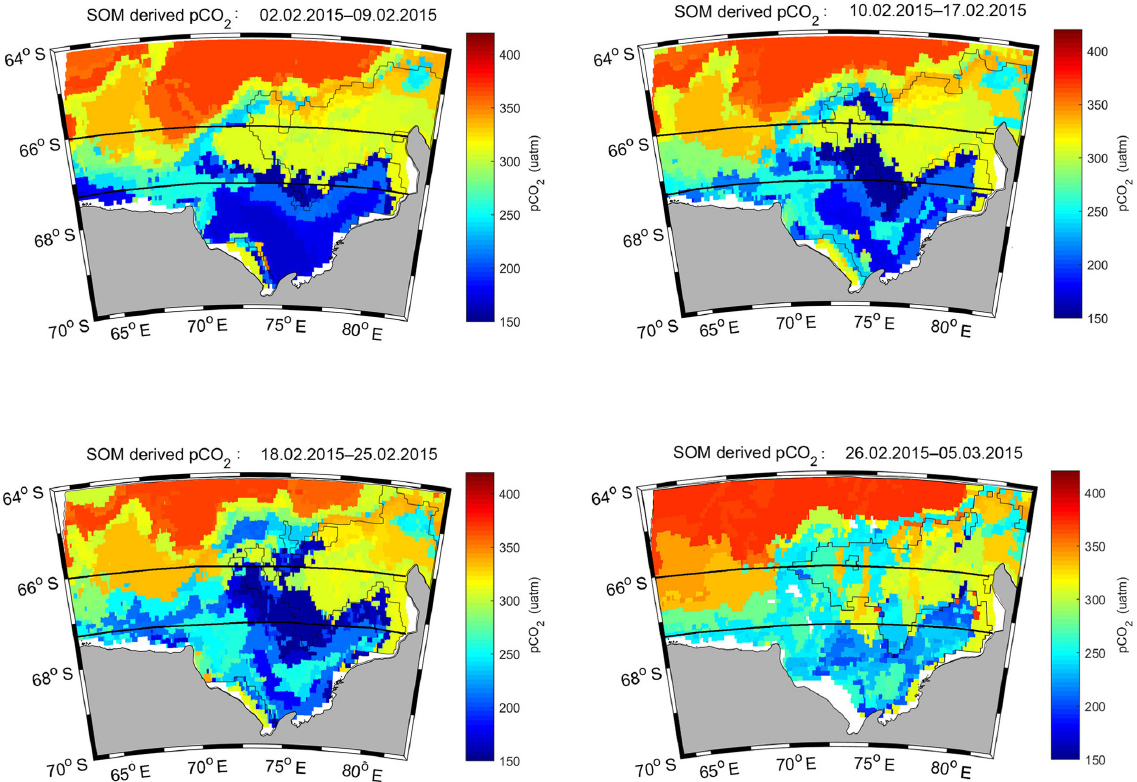
Figure 5. Distribution of weekly mean SOM-derived oceanic p CO 2 in Prydz Bay (in µatm) from 2 February to 5 March 2015. The black contour represents a sea-ice concentration of